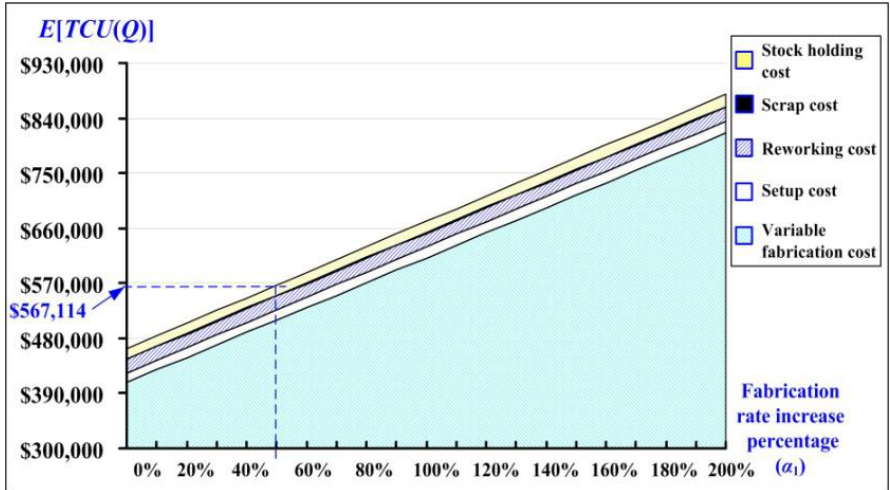
Figure 10. Changes of fabrication rate increase percentage effects on different cost components of E [ TCU(Q)